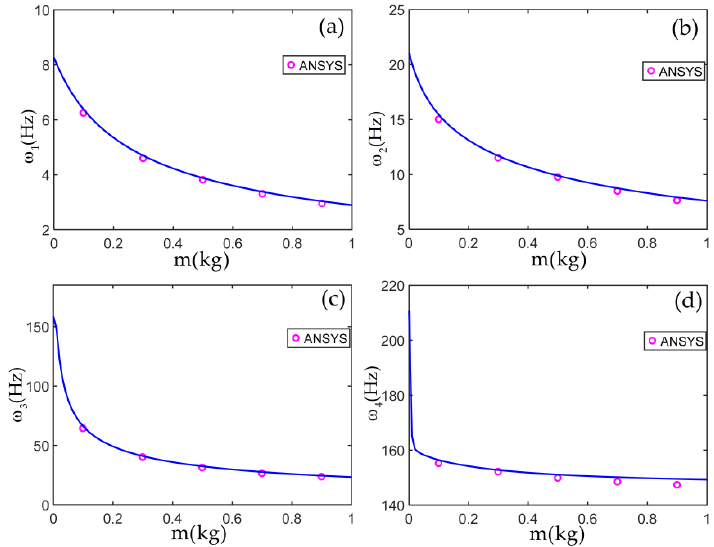
Figure 5. The first four natural frequencies versus m : ( a – d ) 1st to 4th natural frequencies.